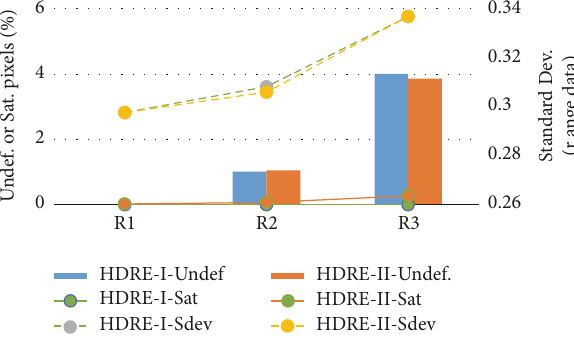
Figure 21: Commutativity in HDRE + GLT and SCI.